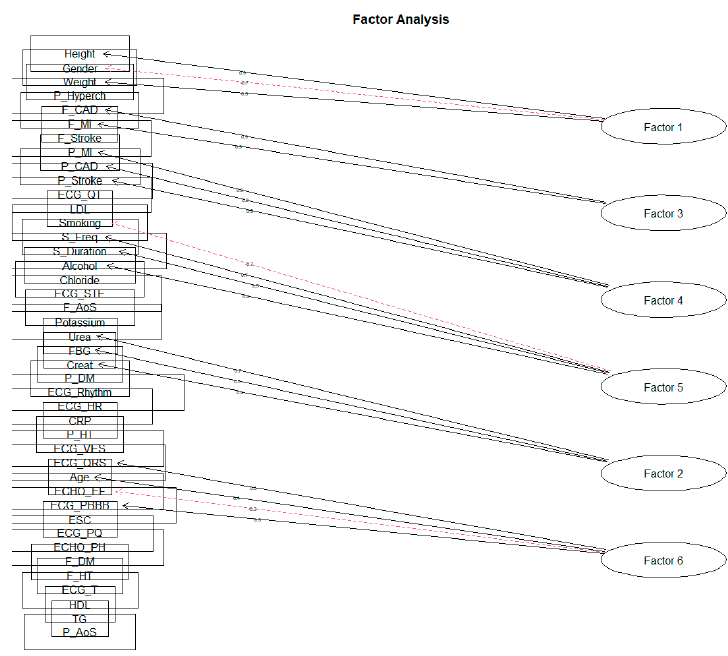
Figure 11. The six-factor solution for rotation Oblimin on the feature set. Table 7. SS loading values with factor loadings for the six-factors FA model with rotation Oblimin.